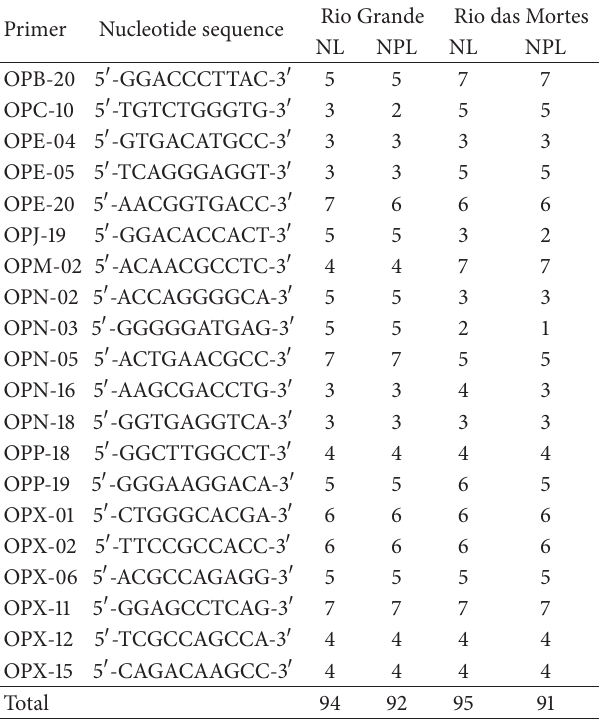
Table 1: Primers, nucleotide sequence, total number of loci (NL), and number of polymorphic loci (NPL) for two analyzed Calophyl- lum brasiliense